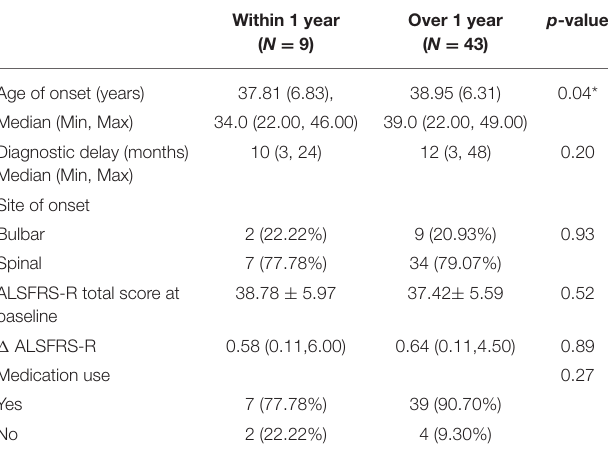
TABLE 4 | Comparison of previous pregnancy and fertility between ALS patients with symptom onset within 1 year and over 1 year after symptom onset.